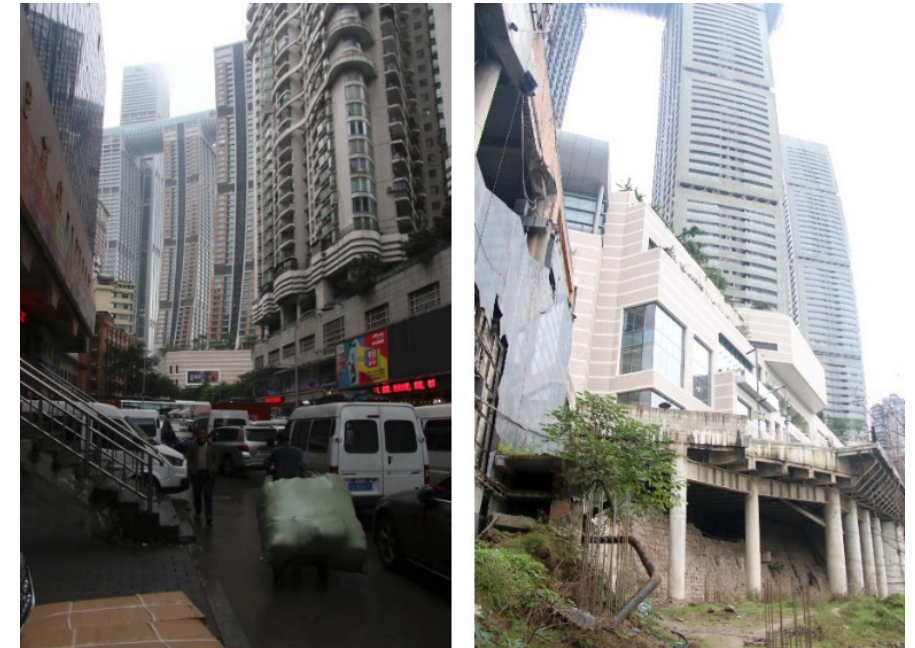
Figure 6. Street blocked by Raffles City (left) and the ancient city wall underneath it (right). been preserved in a vertical way under an affiliated struc‐ ture of Raffles City (see Figure 6, right). In the